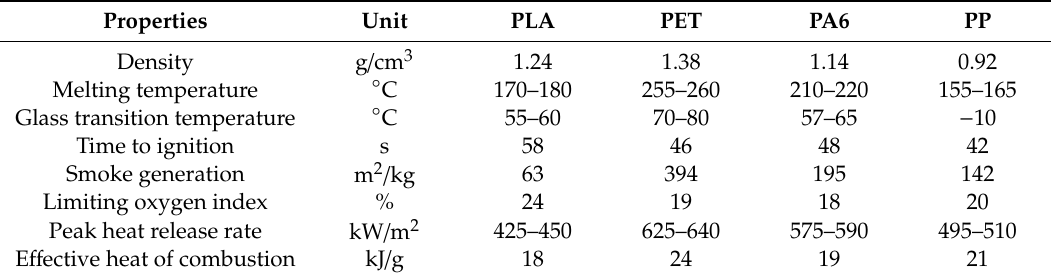
Table 1. Physical and fire related properties of some commercial polymers [28].